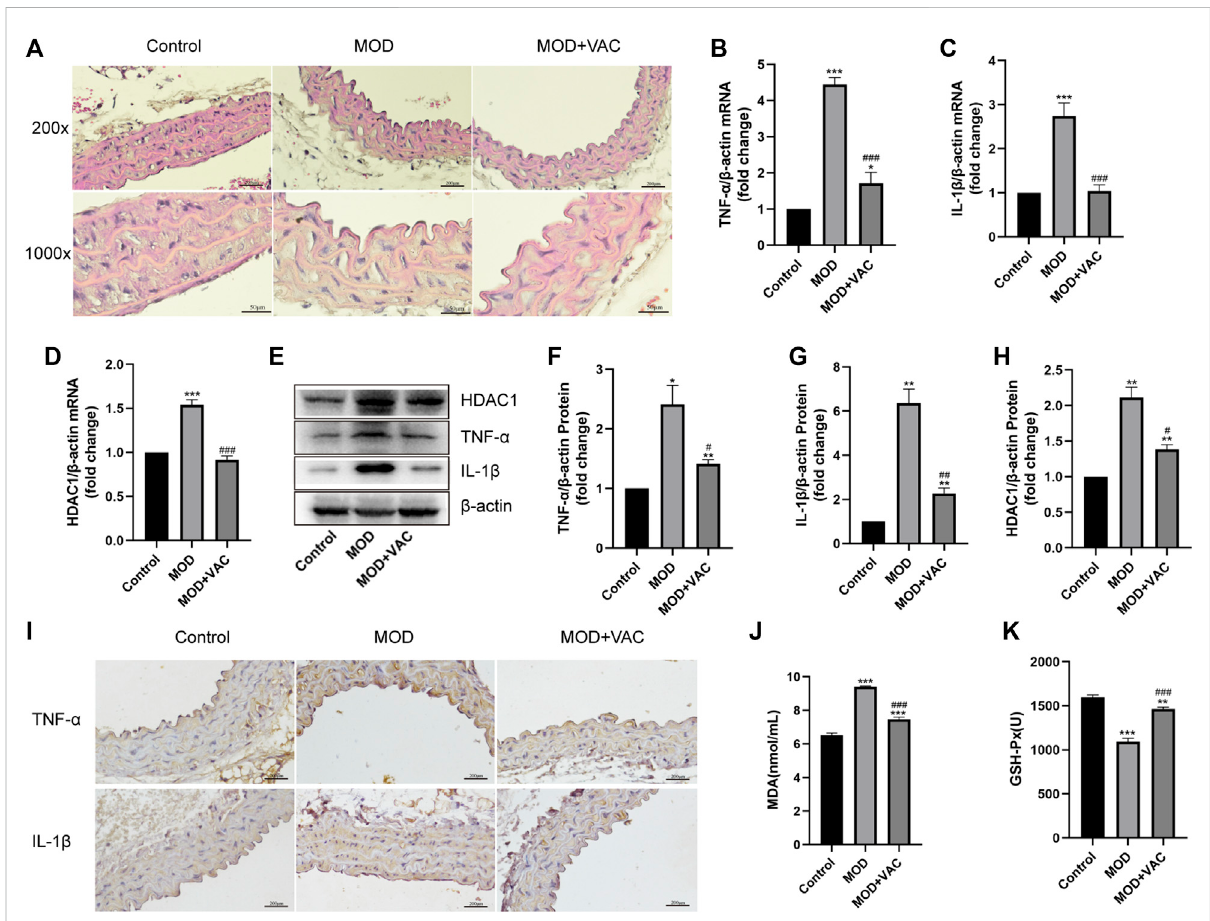
Vaccarin improved aortic in fl ammatory injury in T2DM mice. (A) . Representative photomicrographs of aortic tissue with H&E (200X, 1000X). (B – D) .TheeffectsofvaccarinontheTNF- α mRNA,IL-1 β mRNA,andHDAC1mRNAexpressioninaortictissueincomparisonwithT2DMmice. (E – H) . Western blotting analysis of HDAC1, TNF- α , and IL-1 β protein expression levels in aortic tissue. Gray value of western blotting. (I) . Representative photomicrographs of aortic tissue with immunohistochemical staining for TNF- α and IL-1 β (200X). (J) . Content of serum MDA. (K) . Activity of serum GSH-Px. Values are mean ± SEM. n = 3 in each group. * p < 0.05, ** p < 0.01, *** p < 0.001 vs. Control; # p < 0.05, ## p < 0.01, ### p < 0.001 vs.